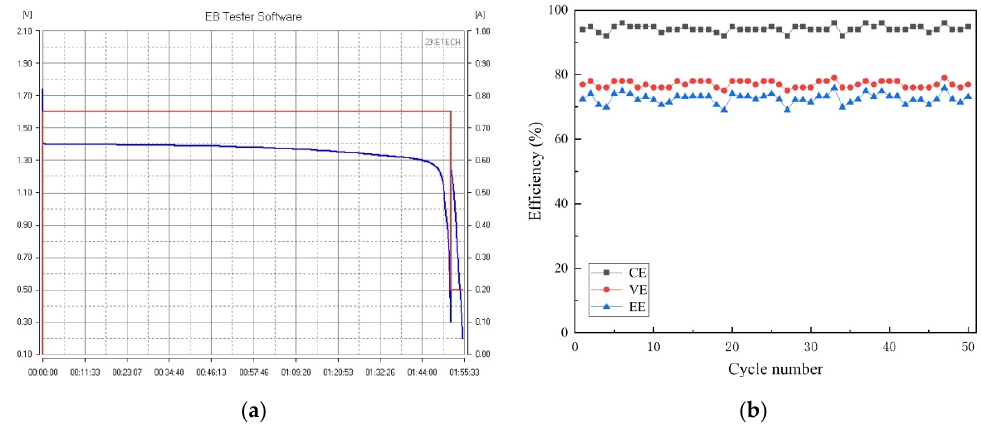
Figure 6. ( a ) 0.75 A constant current discharge test ( b ) Single cell cycle test.